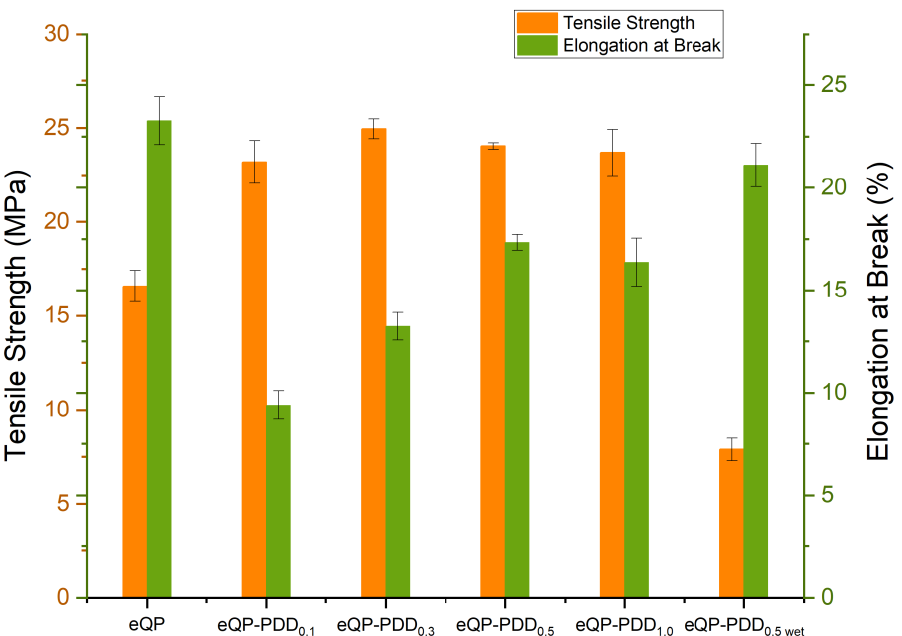
Figure 8. Tensile strength and elongation at break of eQP-PDD x AEMs.